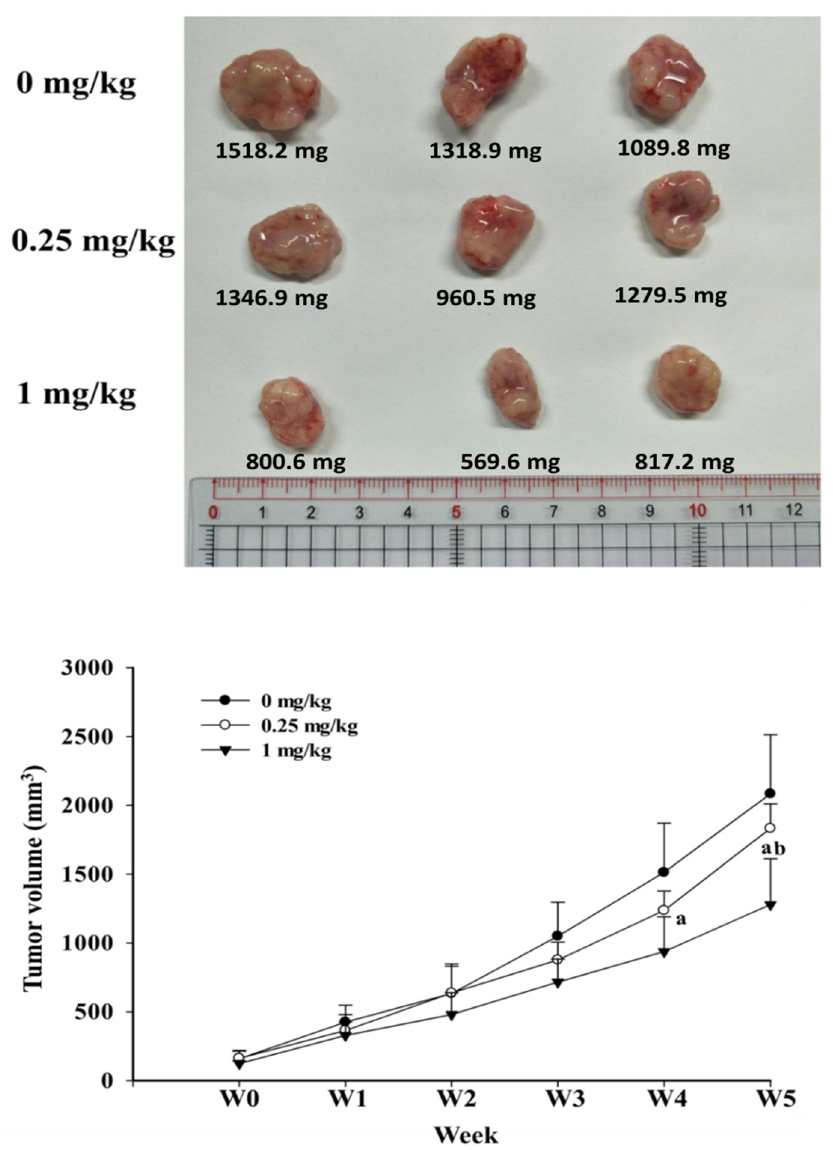
Figure 6. E ff ects of risperidone on xenografted SW480 cells. “a” indicates a significant di ff erence Figure 6. Effects of risperidone on xenografted SW480 cells. “a” indicates a significant difference compared with the control group. “b” indicates a significant di ff erence compared with low-dose compared with the control group. “b” indicates a significant difference compared with low-dose risperidone. The superscript letters “a” and “b” indicate significant di ff erences ( p < risperidone. The superscript letters “a” and “b” indicate significant differences ( p < 0.05).